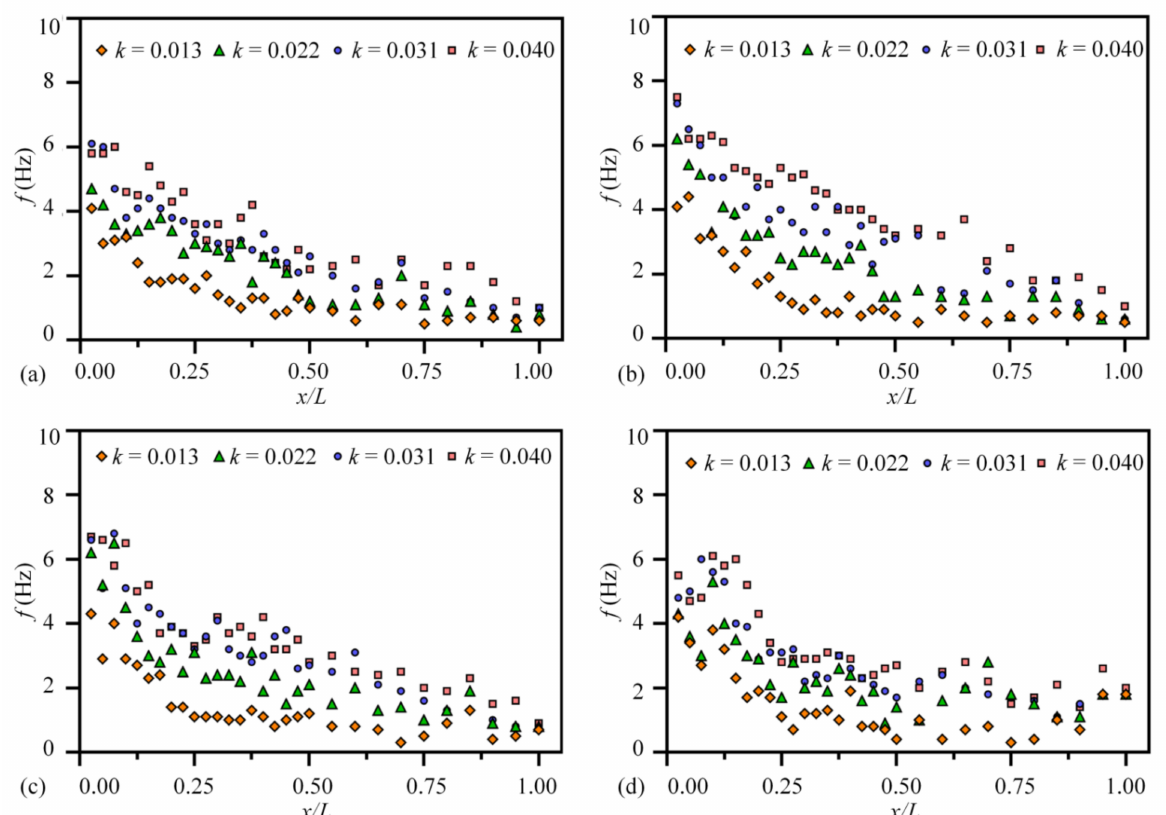
Figure 15. ( a ) TP1, ( b ) TP2, ( c ) TP3, ( d ) TP4 under different flow energy ratio, the distribution of dominant frequencies along the